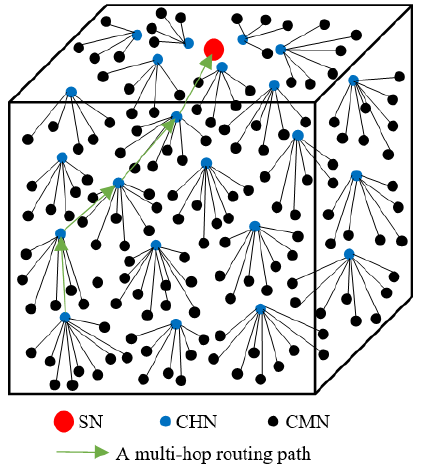
Figure 1. The schematic diagram of the network model.